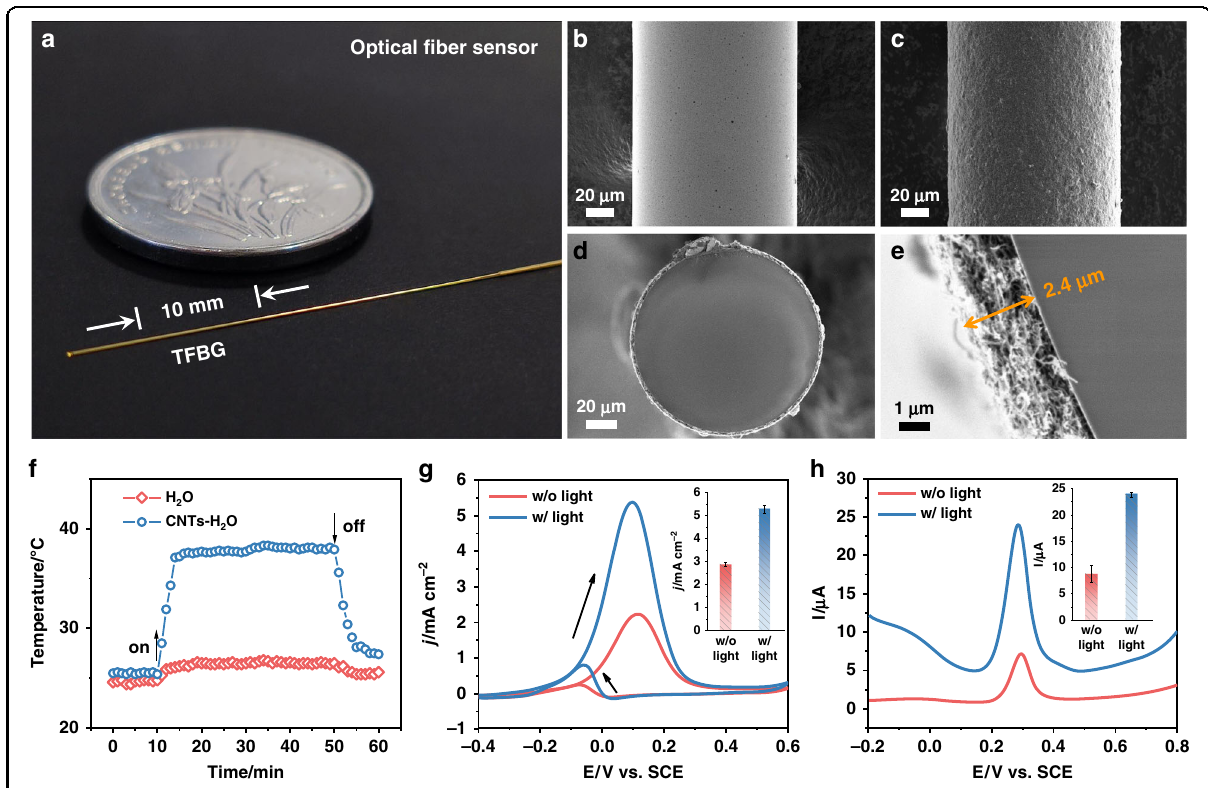
Fig. 2 Photothermal effects in photo-electrocatalytic reactions over optical fi ber surface. a Photograph of Au-FOS. b – e SEM images of Au-FOS ( b ), CNTs/Au-FOS ( c ) and its cross-sections ( d , e ). f Temperature responses of CNTs-H 2 O vs. H 2 O with the light on and off. g , h Comparisons of CNTs/ Au-FOS responses w/ and w/o light irradiation: g , CV behaviors on sensor in 1 M ethanol and 1 M KOH solution. h Differential pulse voltammetry (DPV) behaviors of 20 µM APAP on sensor in 0.1 M phosphate buffer (pH = 7.0). The insets in g and h show the corresponding histograms of electrocatalytic activities. Error bars result from the standard deviation from fi ve